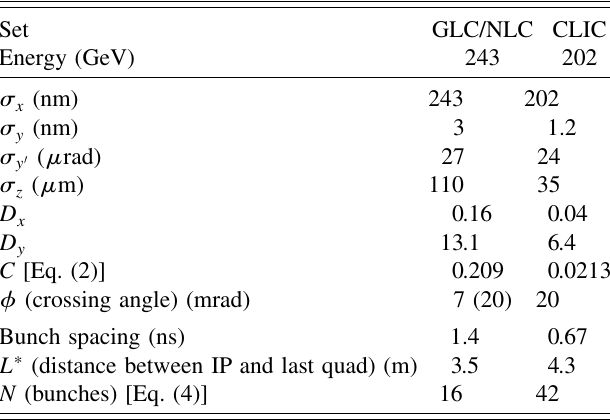
TABLE I. Beam parameter values (at 500 GeV) used from the blowup simulations adopted from the ITRC report [3].